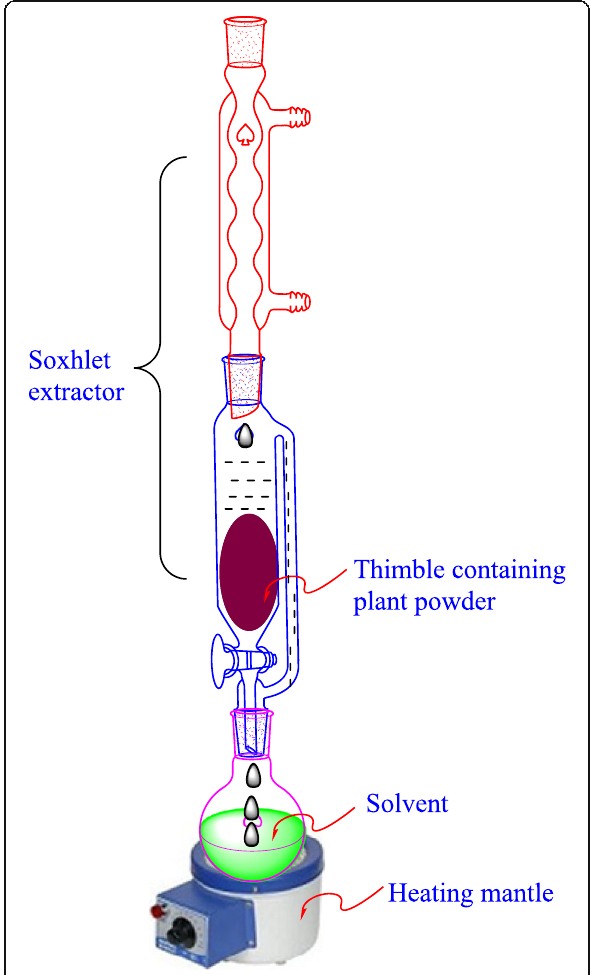
Fig. 1 Soxhlet set up for extraction of crude plant